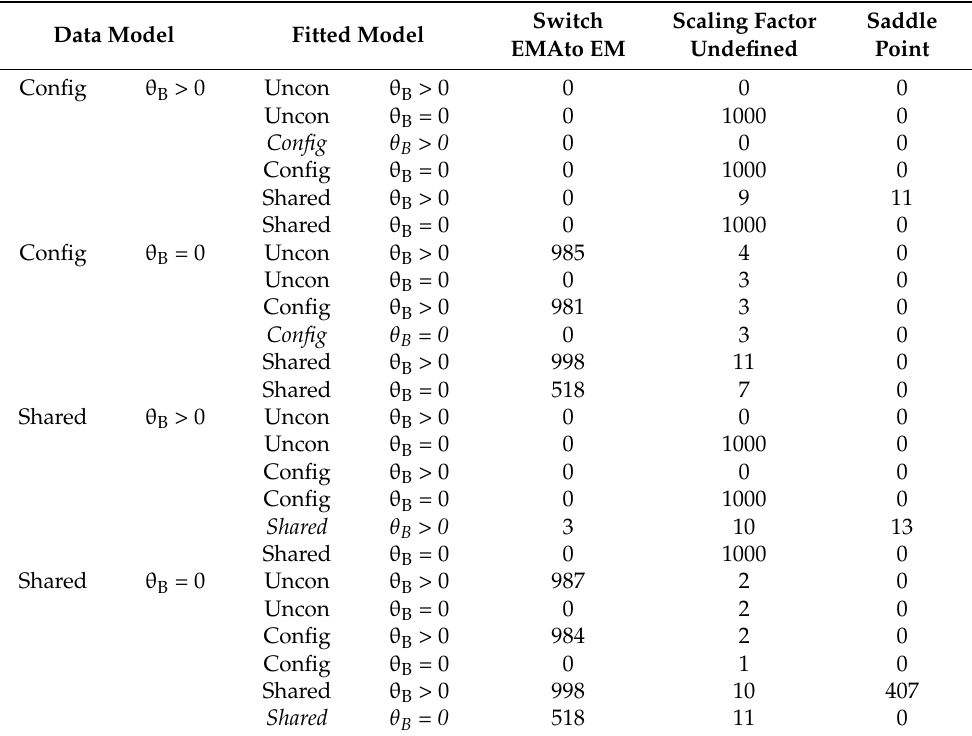
Table A2. Frequency (in 1000 samples) of M plus switch from EMA to EM, undefined scaling correc- tions and saddle point warnings.